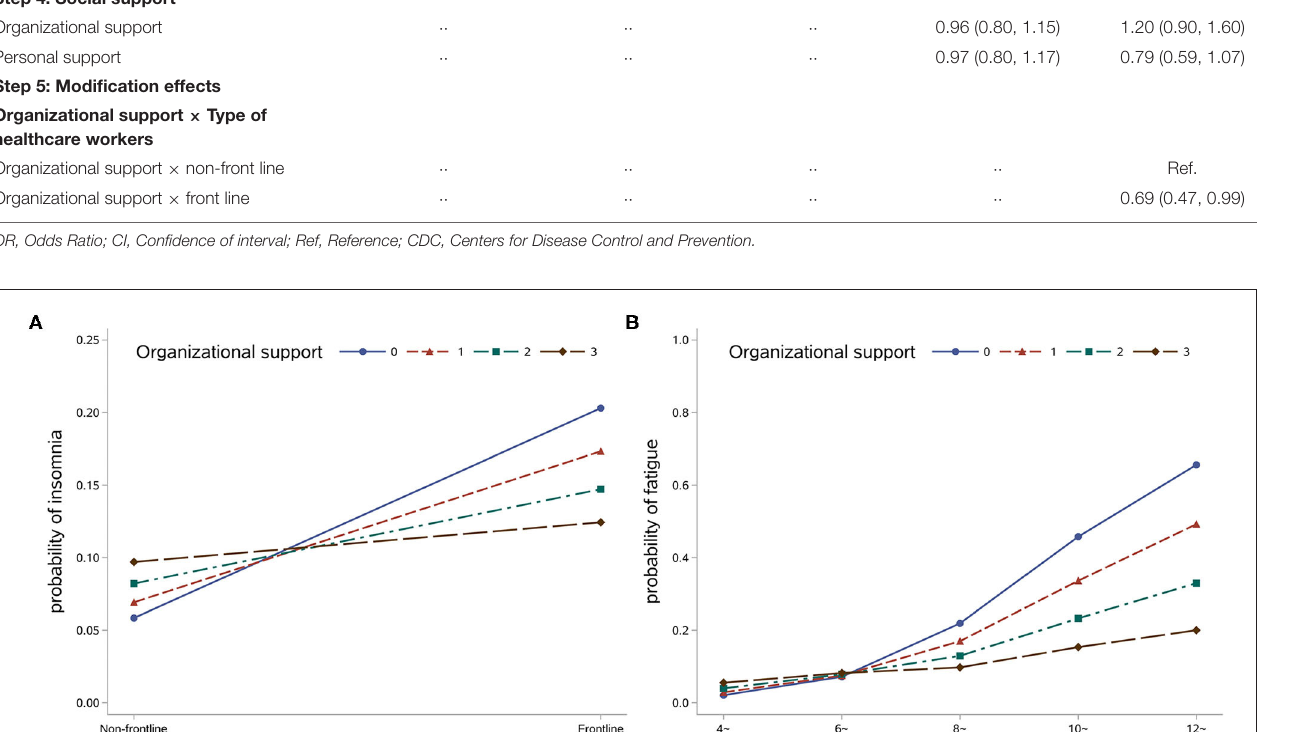
to be at risk of insomnia (4 ∼ h vs. < 4 h: OR = 1.29, 95% CI